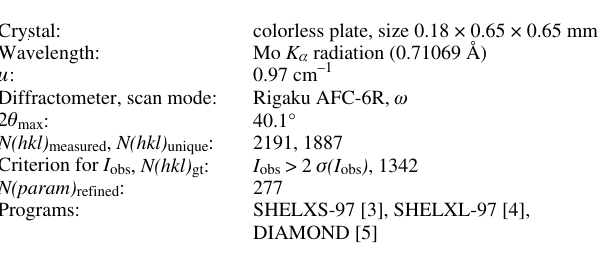
Table 1. Data collection and